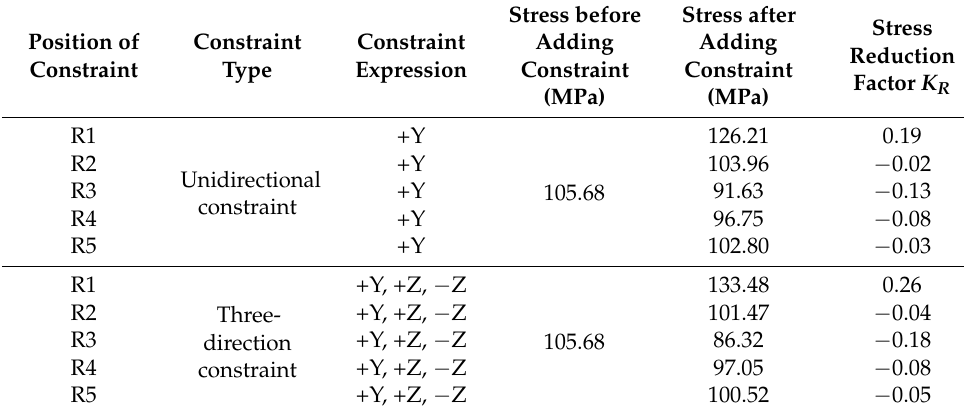
Figure 17. Constraint positions near T1.